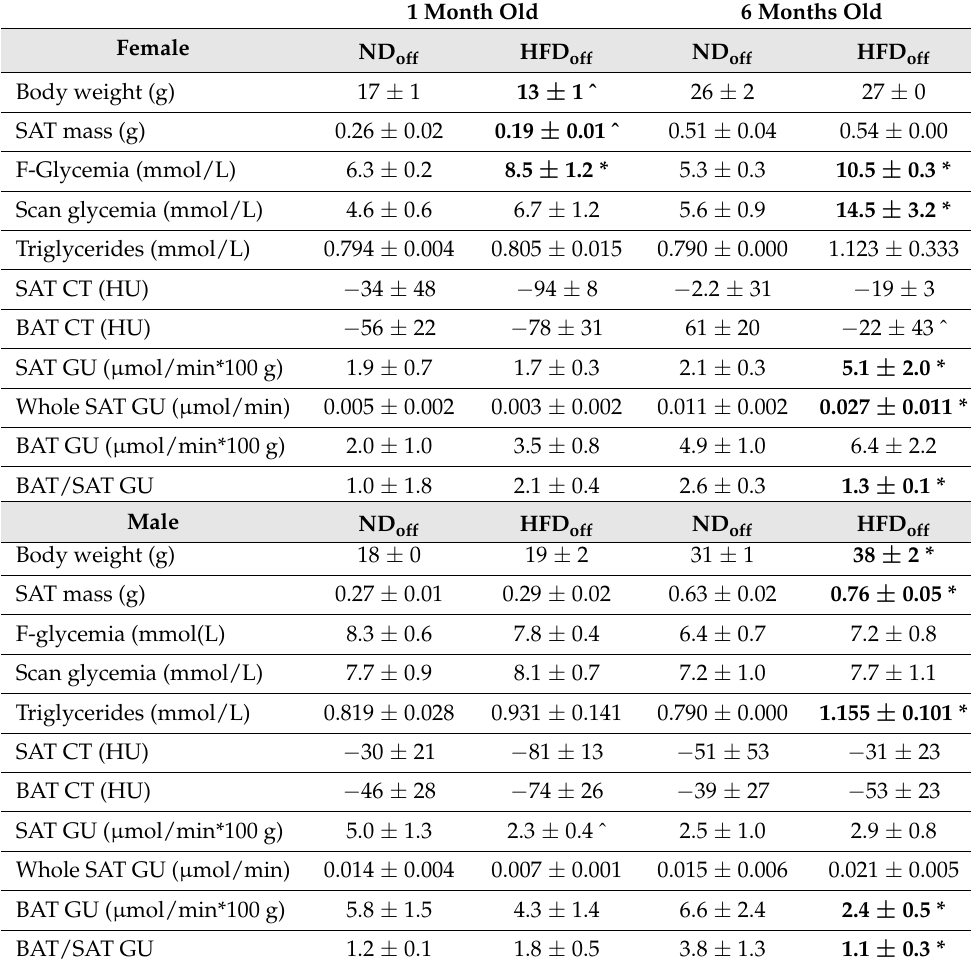
Table 1. Metabolic profile and imaging data stratified by offspring sex, showing similarities of MIO vs. male and MIOR vs. female groups, as explained in the legend of Figure 3. 1 Month Old 6 Months